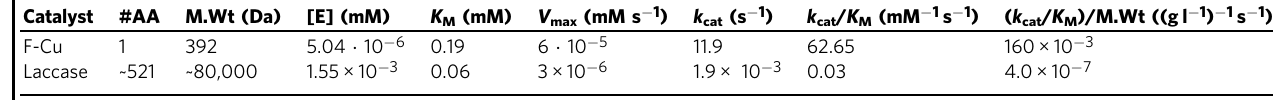
#AA number of amino acids, M.Wt molecular weight.